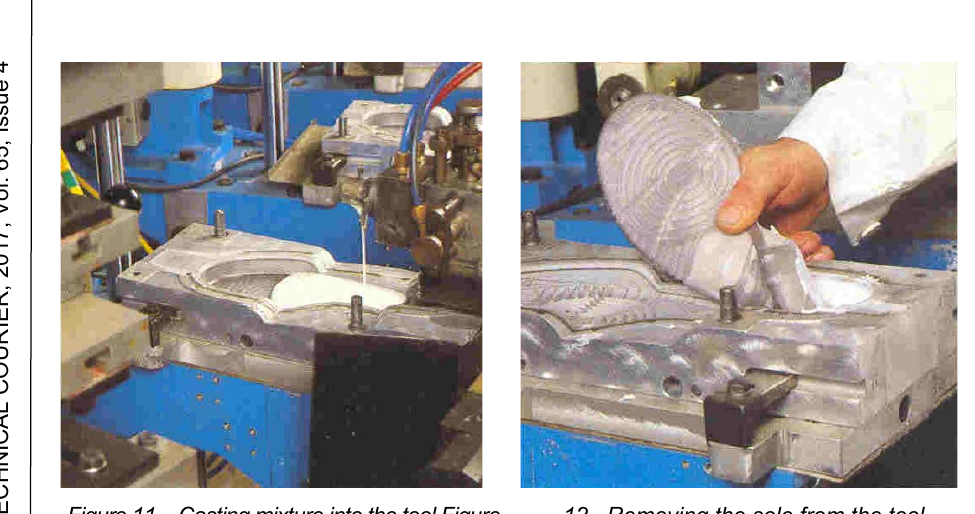
Figure 11 – Casting mixture into the tool Figure Рис . 11 – Заливка форм смесью Слика 11 – Уливање смеше у алат